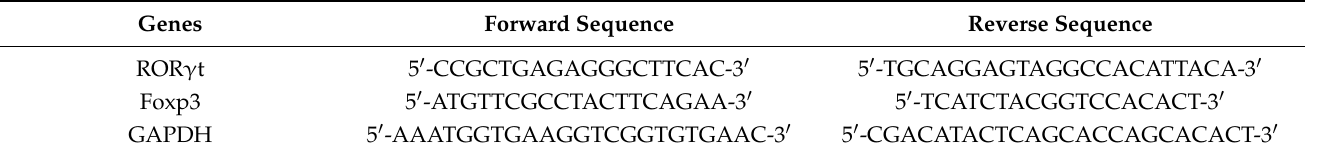
Table 1. The sequences of RT-qPCR